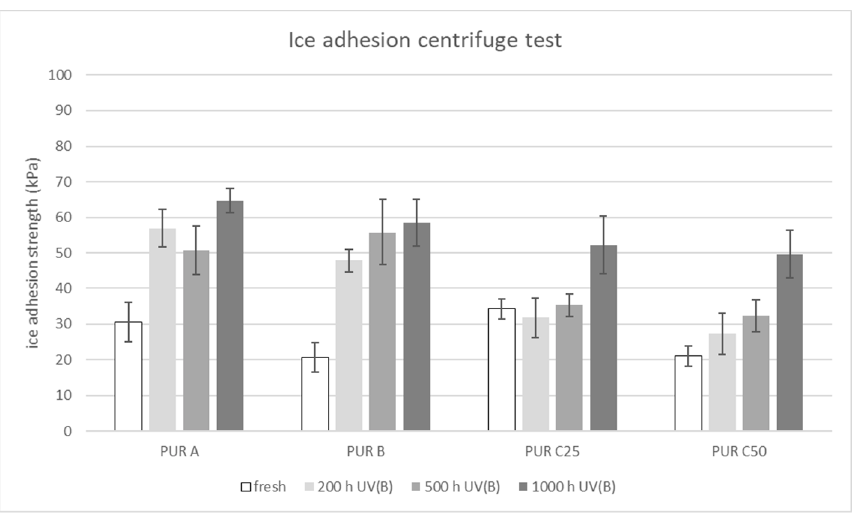
Figure 4. Results of ice adhesion centrifuge test (kPa), representing the mean of nine single meas- urements and resulting standard deviations for coatings prior to and after UV(B)-ageing, as indi-